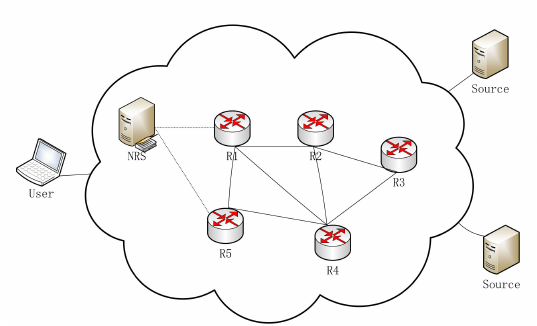
Figure 1. IP-compatible information-centric network (ICN) network